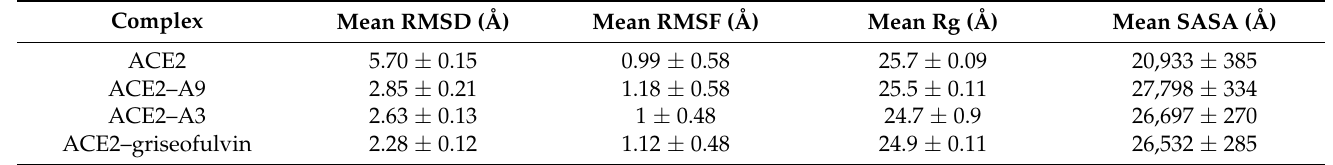
Table 3. The average of RMSD, RMSF, Rg, and SASA for ACE2 during the last 20 ns of MD